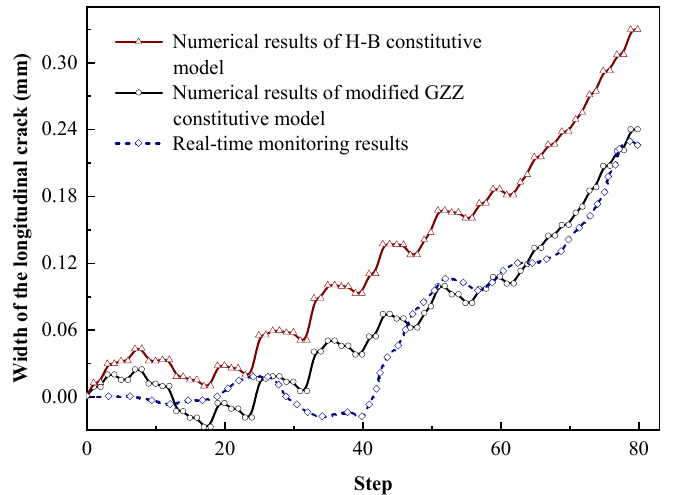
Figure 10. Numerical analysis and real-time monitoring results of width of the longitudinal crack.